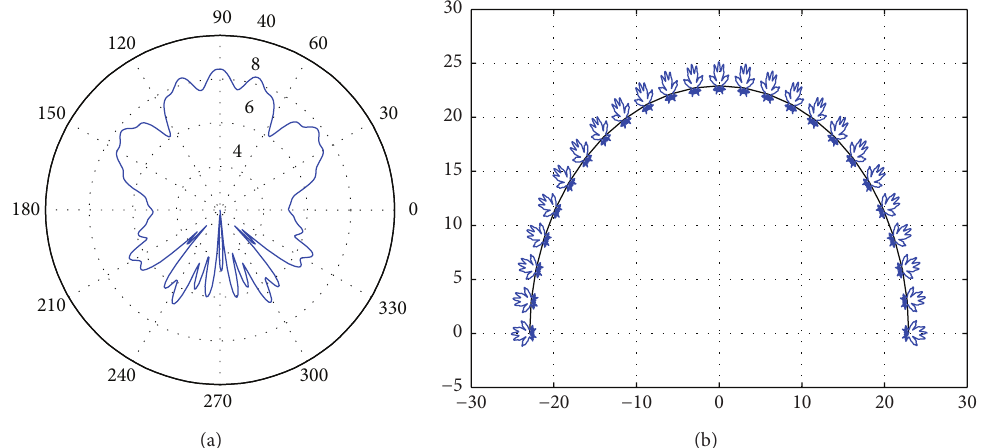
Figure 8: (a) Embedded element antenna pattern for 13th element. (b) Simulating each element pattern under coupling effect.